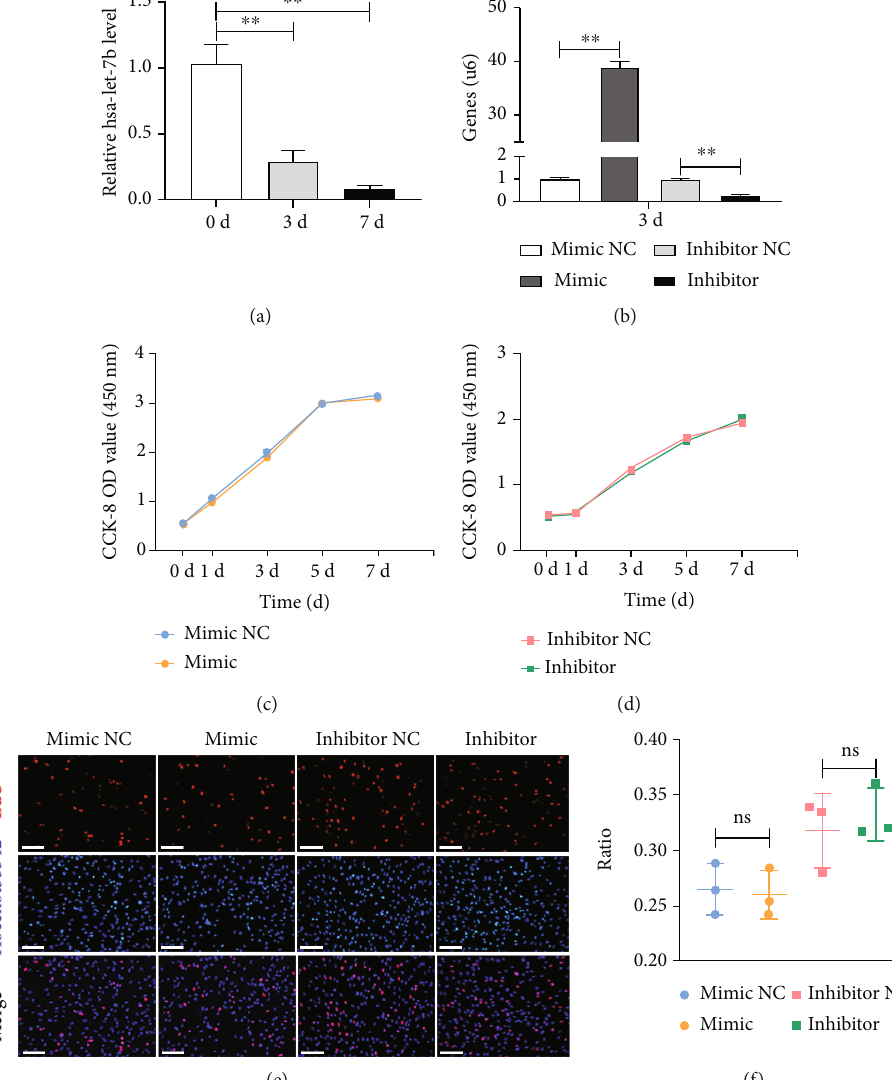
Figure 2: Transfection e ffi ciency and the e ff ect of hsa-let-7b on the proliferation of PDLSCs. (a) The expression of hsa-let-7b during the osteogenic di ff erentiation of PDLSCs for 0, 3, and 7, days, respectively. ∗∗ P < 0 : 01 . (b) Transfection e ffi cacy of hsa-let-7b was measured at day 3 by qRT-PCR. (c) CCK-8 analysis showed that there was no signi fi cant di ff erence between mimic and mimic NC at 0, 1, 3, 5, and 7, respectively. P > 0 : 05 . (d) CCK-8 analysis showed that there was no signi fi cant di ff erence between inhibitor and inhibitor NC at 0, 1, 3, 5, and 7, respectively. P > 0 : 05 . (e, f) Cell proliferation of PDLSCs was detected by EdU staining and assay. P > 0 : 05 . EdU: 5-ethynyl- 2-deoxyuridine; mimic: hsa-let-7b mimics; mimic NC: mimics control; inhibitor: hsa-let-7b inhibitor; inhibitor NC: inhibitor